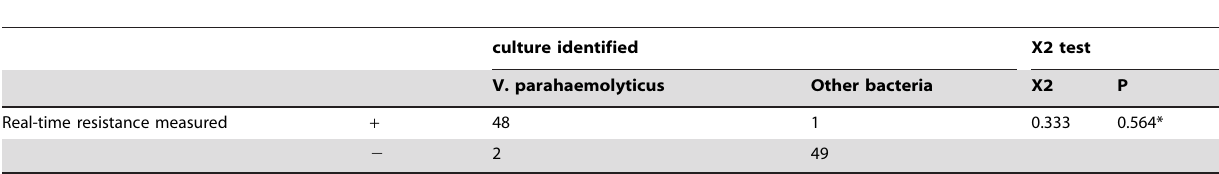
Table 2. Comparison of real-time resistance measurement and culture